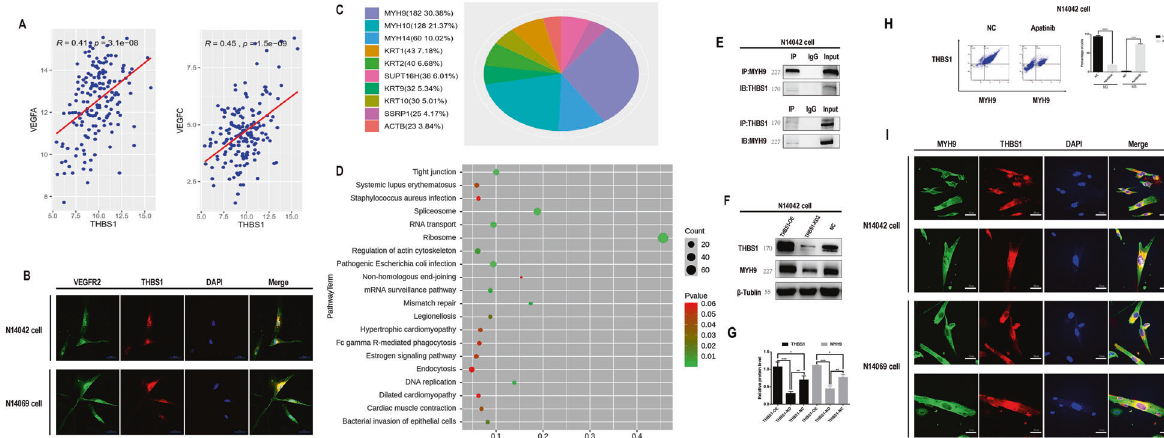
Fig. 6 Interaction between thrombospondin 1 (THBS1) and myosin heavy chain 9 (MYH9)/vascular endothelial growth factor receptor 2 (VEGFR2) in glioma cells. A Analysis of The Cancer Genome Atlas (TCGA) equation THBS1 and VEGFR2 co-expression data sets. B Immuno fl uorescence images of THBS1 and VEGFR2 colocalization in glioma cells. The nuclei were stained with DAPI. Images were captured using a laser confocal microscope. C Immunoprecipitation followed by mass spectrometry showed that the MYH9 peptide showed the highest sequence coverage. D Pathway analysis for MYH9 revealed that the tight junction pathway showed the highest enrichment. E Immunoprecipitation followed by western blot analysis revealed the interaction between THBS1 and MYH9 in glioma cells. F , G Western blot analysis showed that MYH9 protein expression decreased when THBS1 was knocked down. H Representative fl ow double-staining showed that the expression of THBS1 – MYH9 was inhibited after the administration of apatinib. I Immuno fl uorescent images of THBS1 and MYH9 expression in glioma cells. The nuclei were stained with DAPI. Images were captured by a laser confocal microscope. Data are shown as mean ± standard deviation (SD), n = 3, # p = NS, * p < 0.05, ** p < 0.01, *** p < 0.001, **** p < 0.0001, Student ’ s t test.